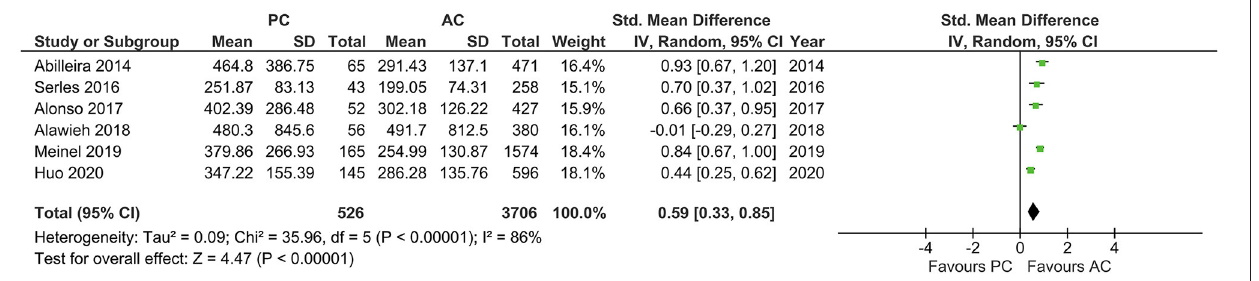
FIGURE 7 | Forest plot comparing “onset-to-groin puncture time” in patients with large vessel occlusion in the posterior circulation (PC) vs. anterior circulation (AC) who were treated with endovascular mechanical thrombectomy. Chi 2 , chi-square statistic; CI, confidence interval; df, degrees of freedom; I 2 , I -square heterogeneity statistic; IV, weighted mean difference; P , p -value; SD, standard deviation; Std., standardized; Tau 2 , estimated variance of underlying effects across studies; Z , Z statistic.